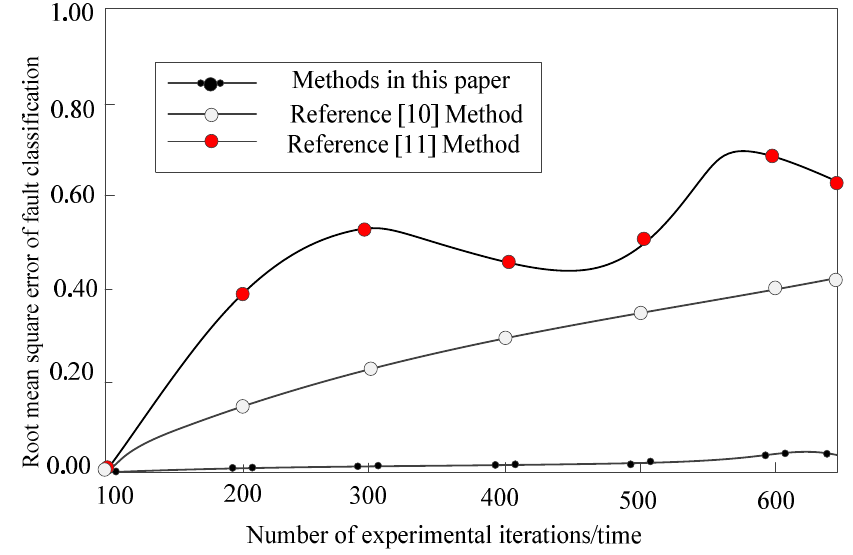
Figure 15. Root-mean-square error of fault classifications [10,11].